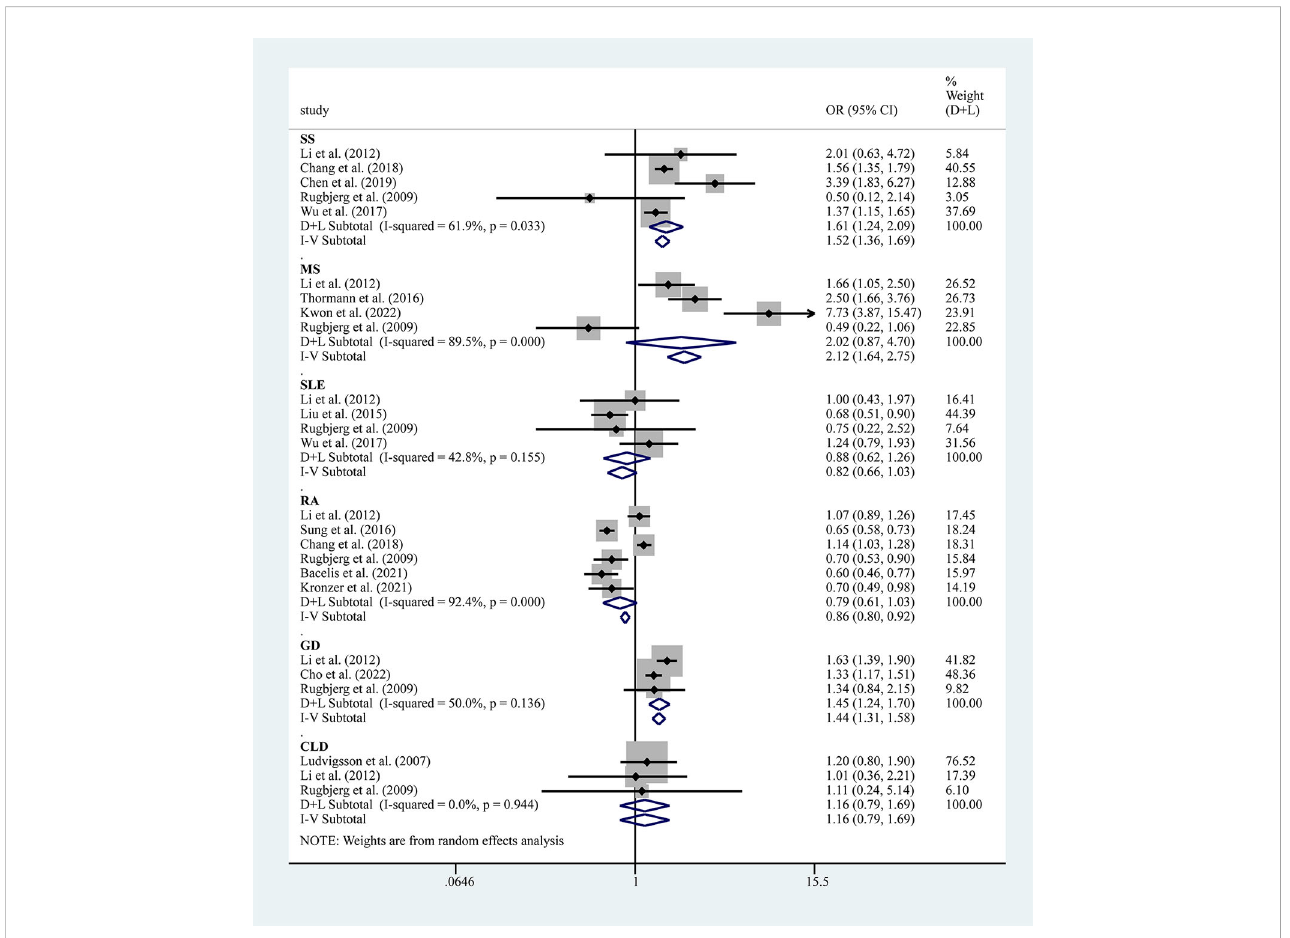
FIGURE 5 Forest plots of studies association between PD and AIDs (including SS, SLE, MS, RA, GD and